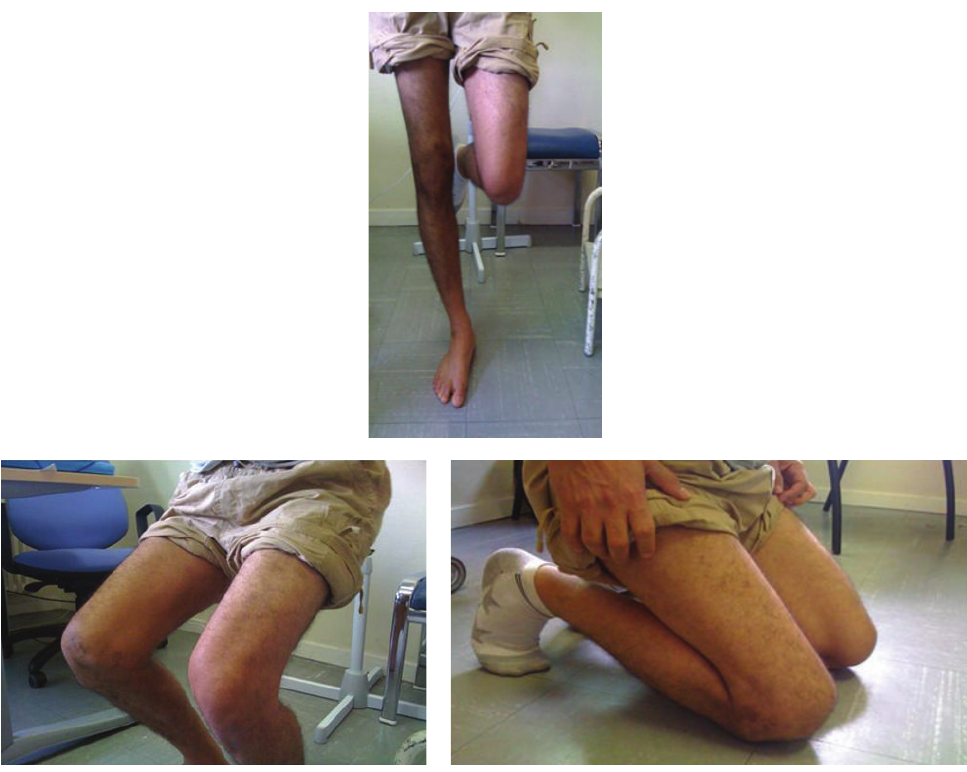
Figure 4: Postoperative photographs: stability, no